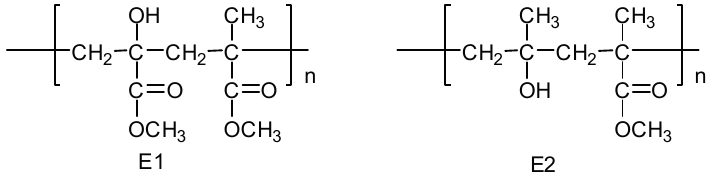
Figure 6. Formation of polymeric alcohols E 1 and E 2 .